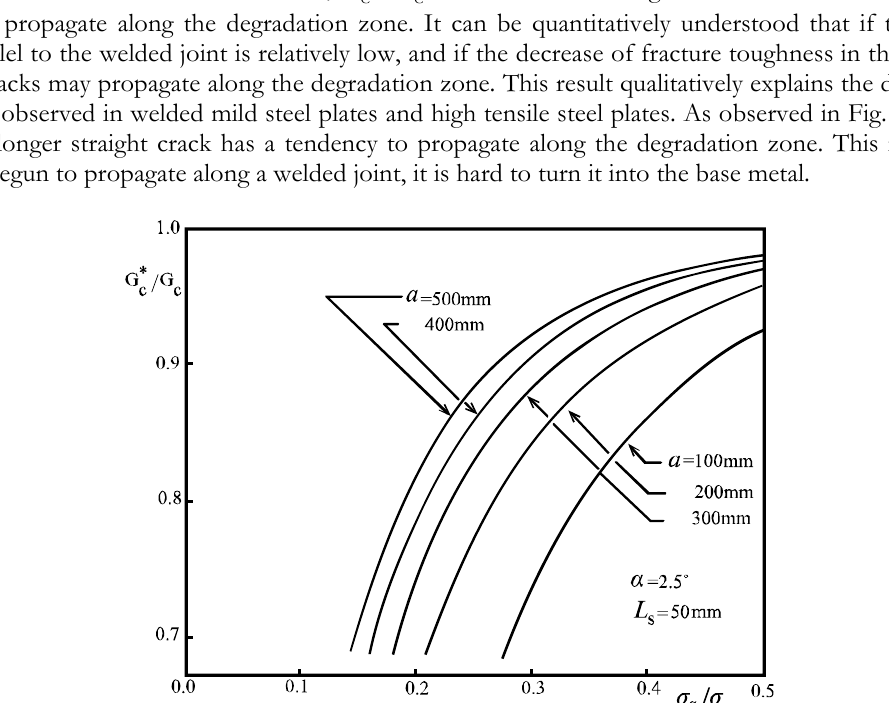
Figure 12: Critical relations between the material degradation and the applied stress; cracks penetrate into the base metal for the conditions corresponding to the upper left regions with respect to the curves [7,